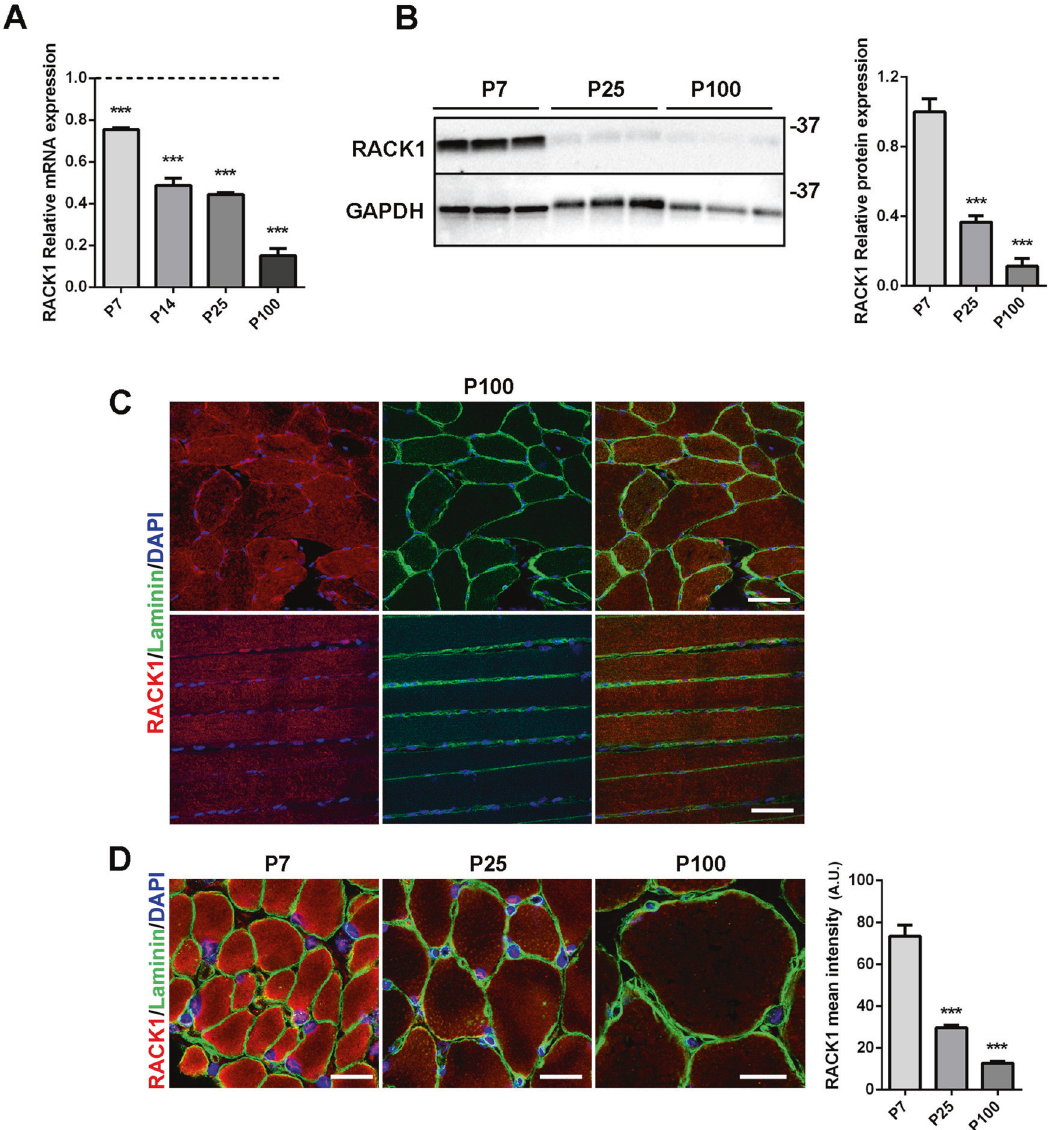
Fig. 1 RACK1 expression in postnatal mouse muscle growth. A mRNA levels of RACK1 by RT-qPCR in TA muscle of P0, P7, P14, P25, and P100 mice. Results are expressed as fold change of P0 (dashed line). *** P < 0.001 vs P0 mice. B Western blot analysis of RACK1 in TA muscle of P7, P25, and P100 mice. GAPDH was used as internal standard. Right panel: densitometric quanti fi cation of RACK1; results are expressed as fold change of P7. *** P < 0.001 vs P7 mice. C Confocal fl uorescence imaging of RACK1 (red), Laminin (green), and DAPI (blue) in transversal (upper panels) and longitudinal (lower panels) TA muscle sections of P100 mice (scale bars: 40 µm). D Confocal fl uorescence imaging of RACK1 (red), Laminin (green), and DAPI (blue) in transversal TA muscle sections of P7, P25, and P100 mice (scale bars: 20 µm). Right panel: mean